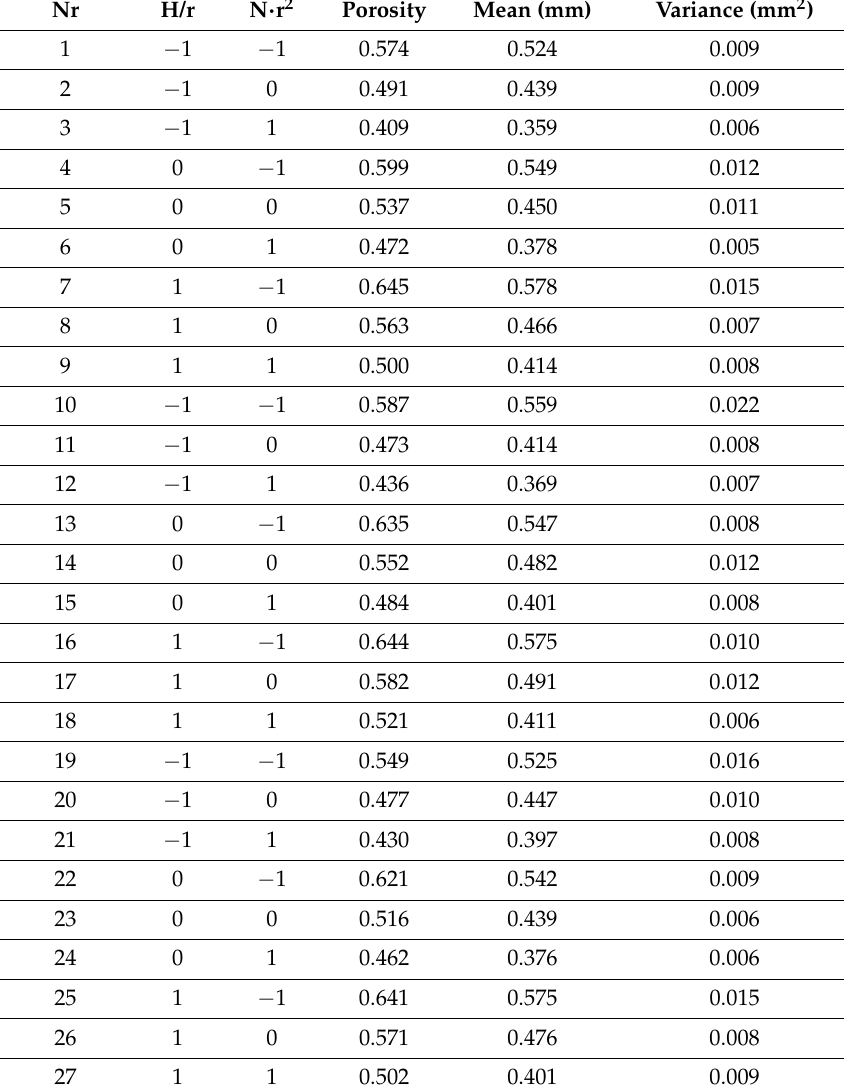
Table 4. Results of the porosity, the mean of the pore size, and the variance of the pore size.